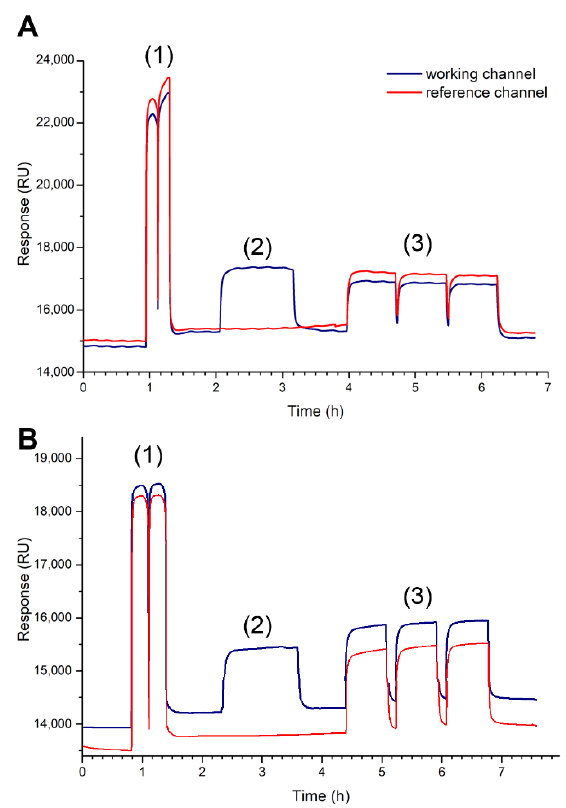
Figure 2. Sensorgrams of the construction process of the mutated thrombophilia (MT) biosensor ( A ) and normal thrombophilia (NT) biosensor ( B ). Sequentially, the observed responses correspond to (1) the activation stage using EDC / NHS; (2) the immobilization stage of the aminated thrombophilia strands (animated mutated thrombophilia (MT-A) and animated normal thrombophilia (NT-A), respectively); and finally (3) the blocking stage using ethanolamine.